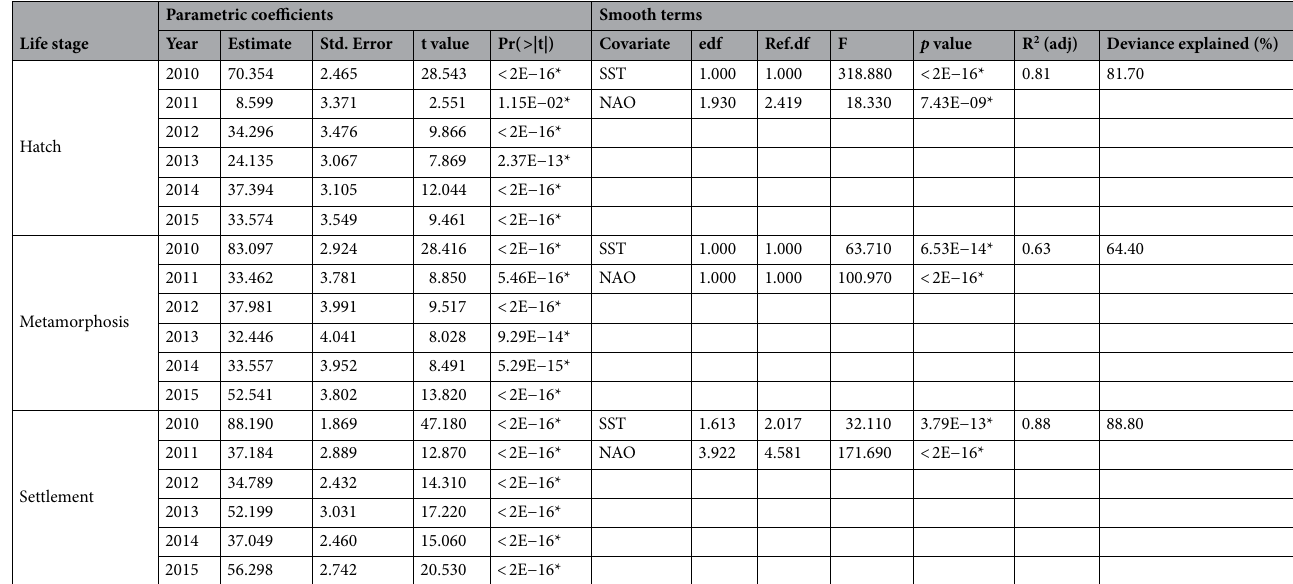
Table 3. Generalized additive model (GAM) outputs for parametric coefficients and smooth terms testing the interaction between environmental variables and Solea solea hatch, metamorphosis, and settlement days between 2010 and 2015. Significant terms are highlighted with